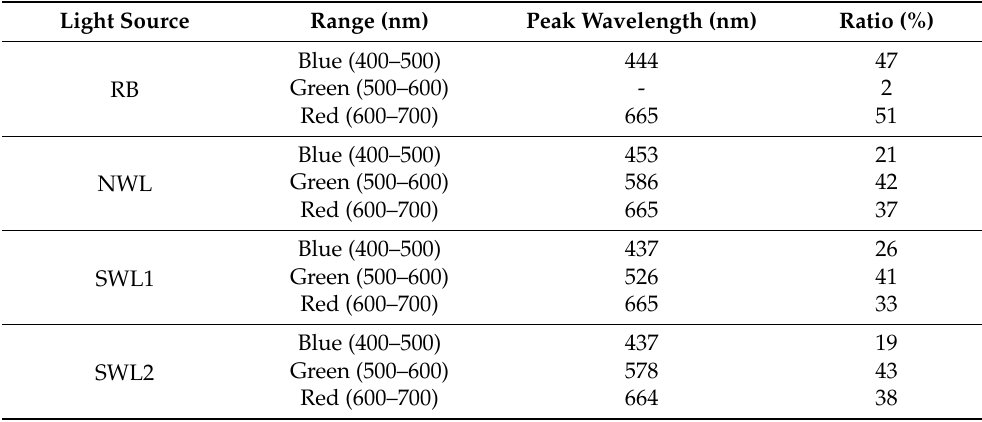
Table 1. Peak wavelengths and spectral distribution of each light source used in this